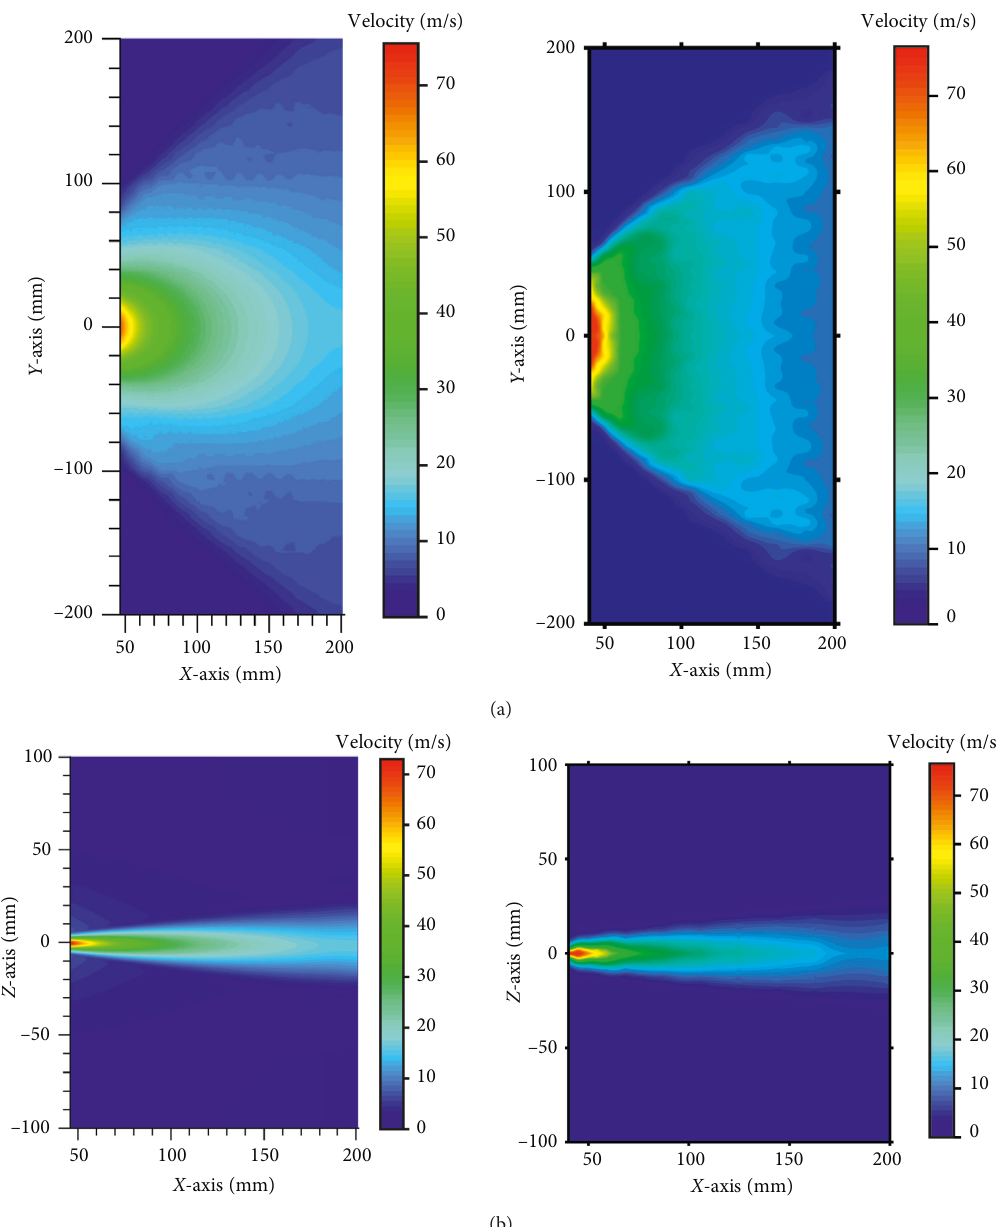
Figure 5: Comparison of computational and experimental gas velocity distribution. (a) Contours on the X - Y plane (left: calculation; right: experiment); (b) contours on the X - Z plane (left: calculation; right: